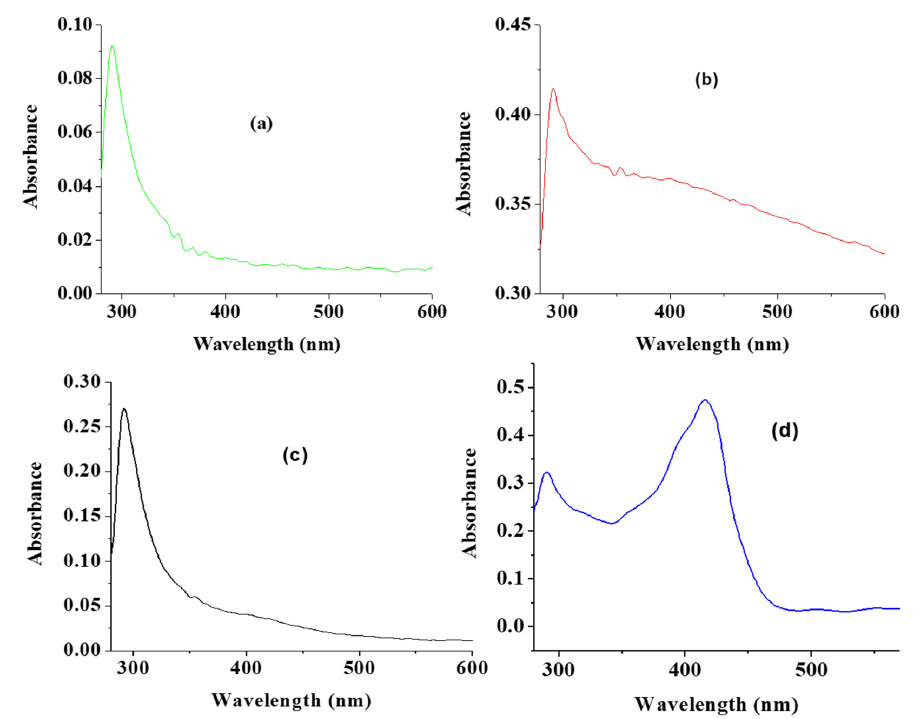
Figure 1. UV-vis spectra of ( a ) CuO obtained using traditional chemical means (cCuO), ( b ) CuO obtained using deionized water (wCuO), ( c ) CuO obtained using acetone (aCuO) and ( d ) CuO obtained using ethanol (eCuO). Nanomaterials 2020 , 10 , x FOR PEER REVIEW